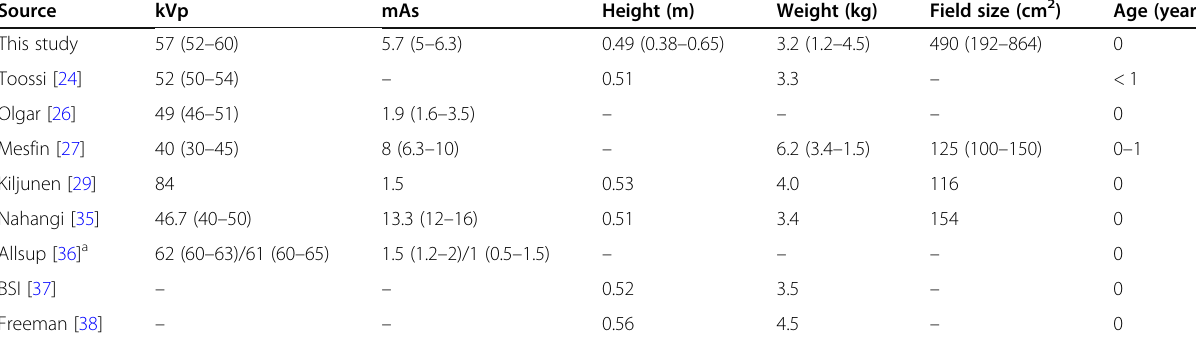
Table 8 Comparison of technical/patients ’ parameters with other studies Source